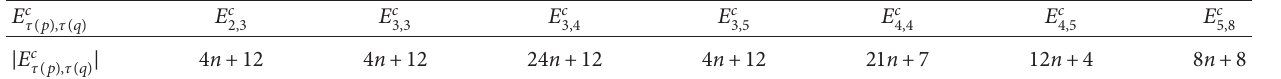
Table 4: Partition of H ’s edges according to the connection